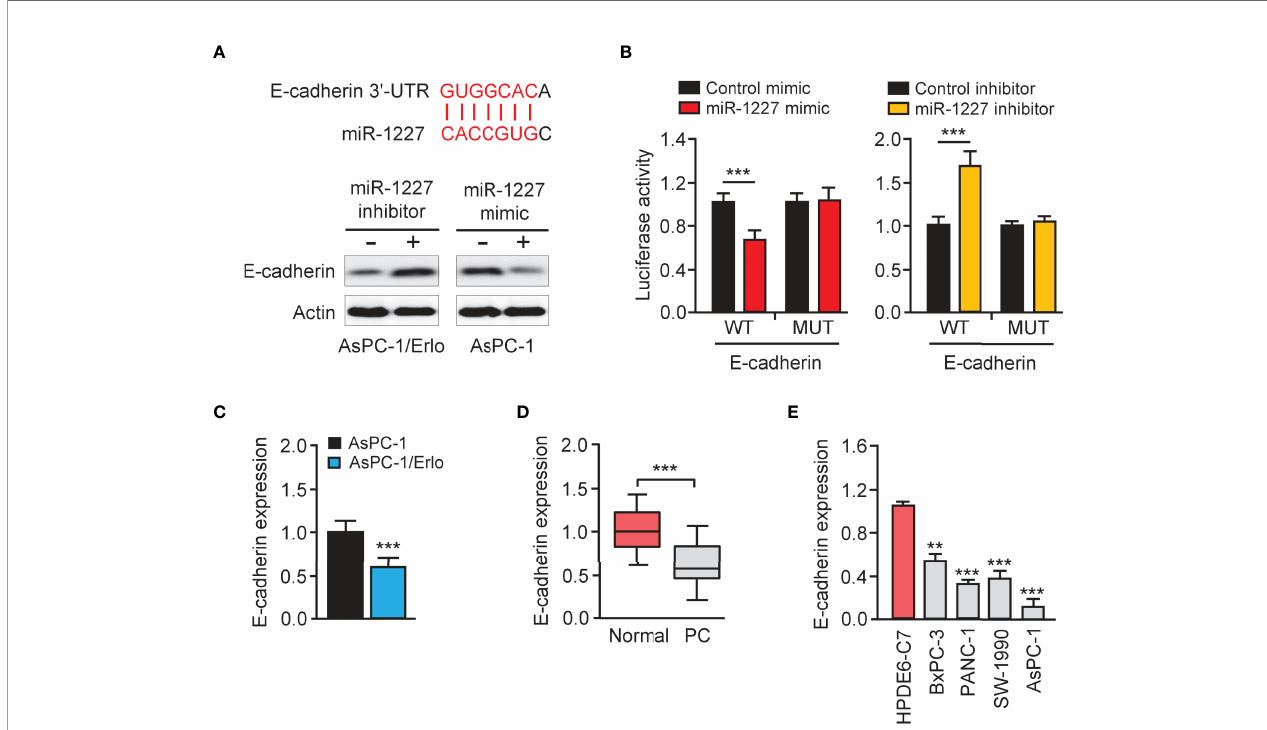
FIGURE 6 | E-cadherin is a direct target gene of miR-1227. (A) Upper panel: schematic diagram of the predicted miR-1227 binding site for E-cadherin 3 ′ -UTR. Bottom panel: western blot analysis of E-cadherin expression in pancreatic cancer cells transfected as indicated. (B) Luciferase activity of WT or MUT E-cadherin 3 ′ - UTR in AsPC-1 cells after co-transfection with miR-1227 mimic, and in AsPC-1/Erlo cells after co-transfection with miR-1227 inhibitor. (C) qRT-PCR analysis of E- cadherin expression in AsPC-1/Erlo and AsPC-1 cells. (D) qRT-PCR analysis of E-cadherin expression in pancreatic cancer and normal tissues. (E) qRT-PCR analysis of E-cadherin expression in pancreatic cancer cell lines and normal cells. ** P < 0.01, *** P